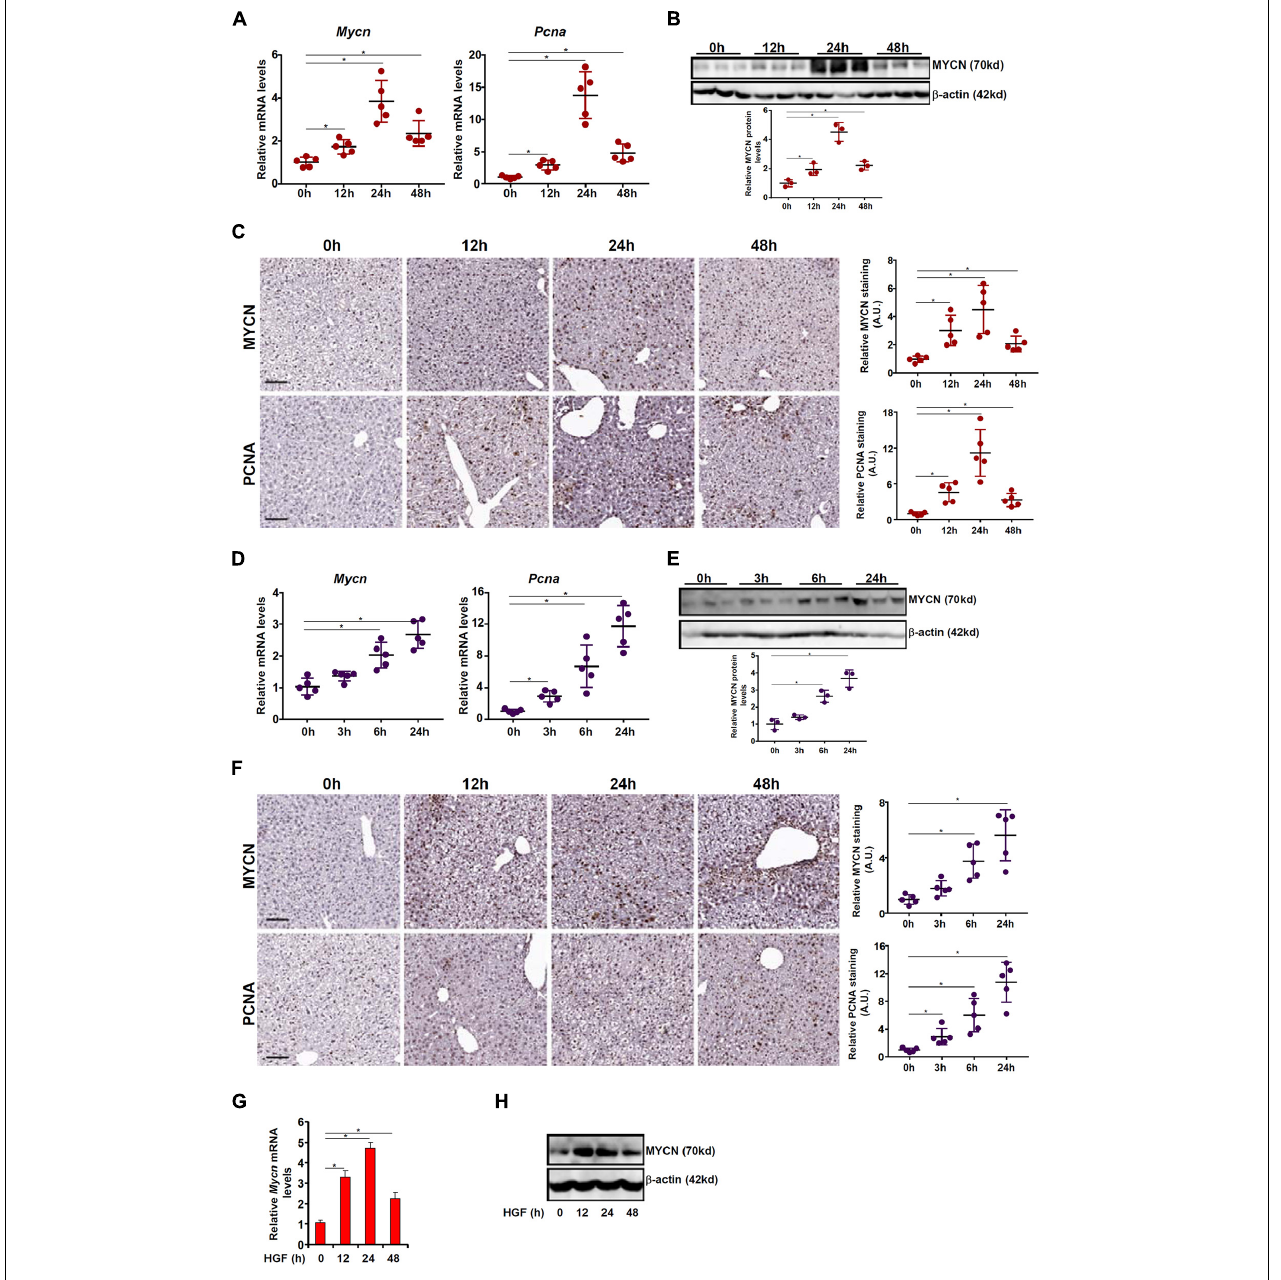
FIGURE 1 | MYCN up-regulation parallels hepatocyte proliferation in vivo and in vitro . (A–C) C57B6/L mice were injected with APAP (300 mg/kg) and sacrificed at indicated time points. MYCN expression was examined by qPCR, Western blotting, and immunohistochemical staining. (D–F) C57B6/L mice were subjected to ischemia-reperfusion and sacrificed at indicated time points. MYCN expression was examined by qPCR, Western blotting, and immunohistochemical staining. (G,H) Primary murine hepatocytes were treated with HGF and harvested at indicated time points. MYCN expression was examined by qPCR and Western. Data are expressed as mean ± standard deviation (SD). * p <0.05 (one-way ANOVA with post hoc Scheffe test).